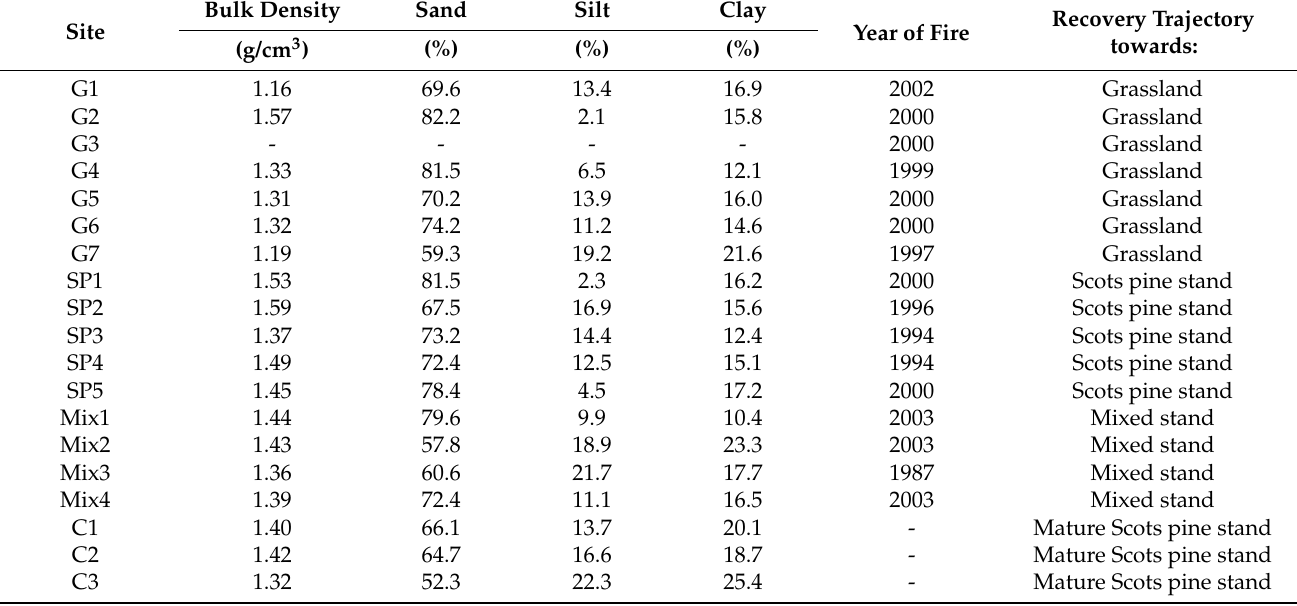
Table 1. Site characteristics in a boreal forest-steppe zone of southern Siberia (data collected in 2018) for sites that were dominated by grass (G), Scots pine (SP), a mixture of species (Mix) and mature Scots pine (C), respectively. The dash sign (-) indicates that data are not available (in the case of site G3, as a result of extreme weather preventing soil sampling).